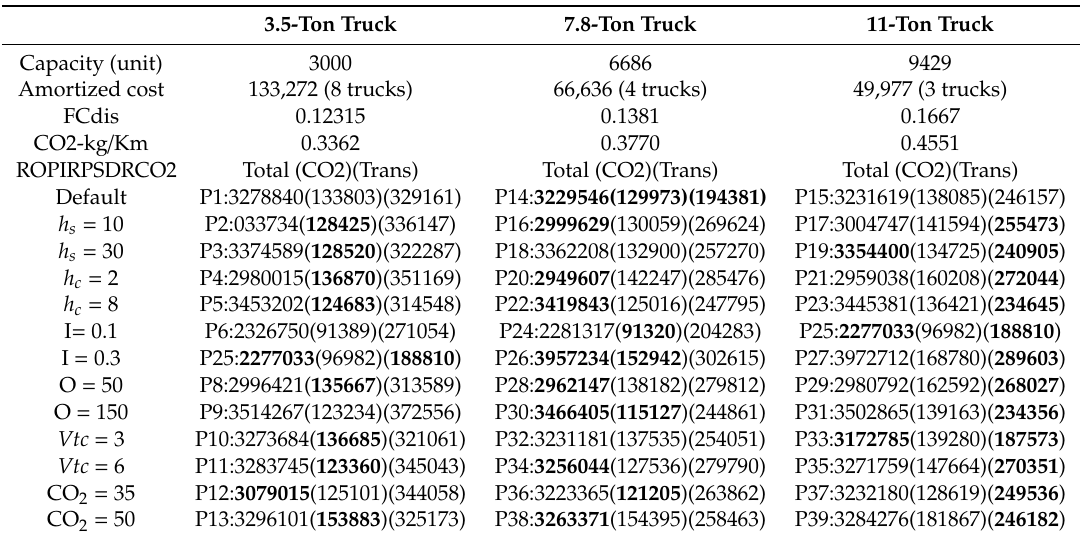
Table 20. The results of the sensitivity analysis for truck loading capacity regarding ROPIRPSDRCO 2 1,2